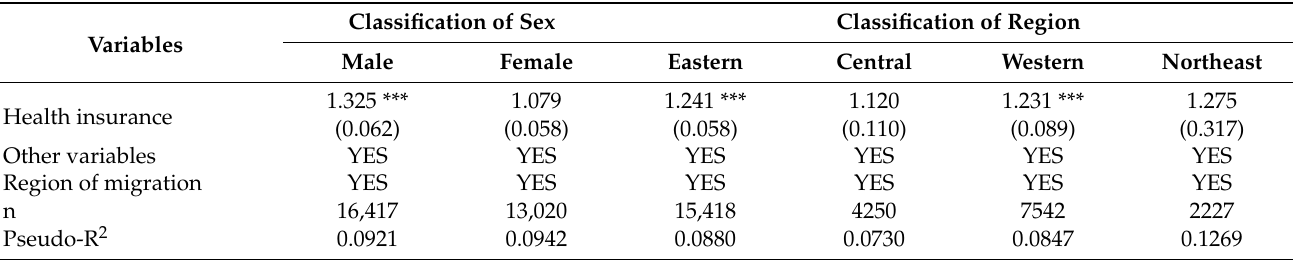
Table 6. Results of sex and regional